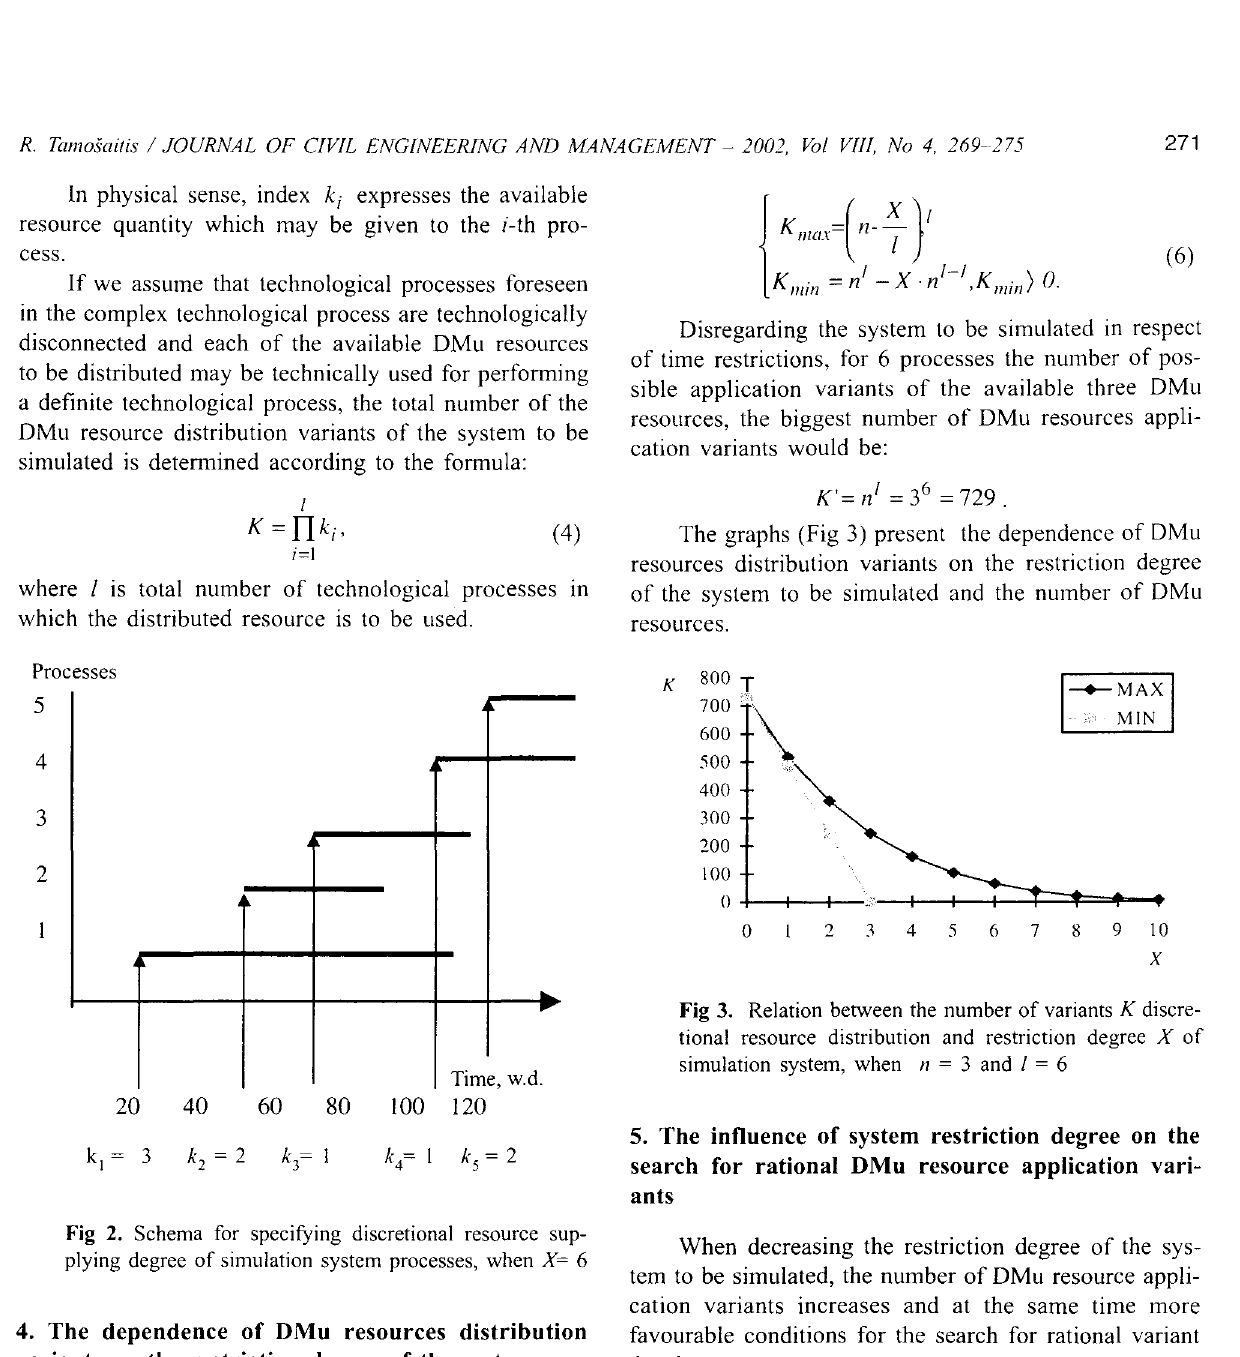
Fig 2. Schema for specifYing discretional resource sup plying degree of simulation system processes, when X= 6